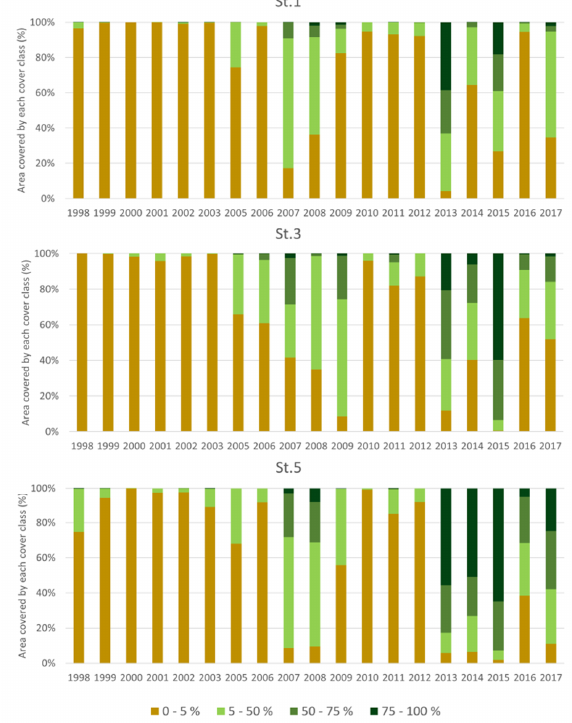
Figure 8. Trends (expressed in %) in the four classes of bottom coverage for the 3 stations during the period 1998–2017: 0 to 5% corresponds to bare sediment; 5 to 50%, sparse vegetation; 50 to 75% moderately dense macrophyte meadows; and 75 to 100%, dense macrophyte meadows. Table 3. Seasonal Kendall tests of the hydrochemical parameters: Kendall’s tau, significance of trend (p), and Sen´s slope estimator in units y –1 . Period: 1998–2017 (except for transparency in St.5, measured from 2000 onwards).